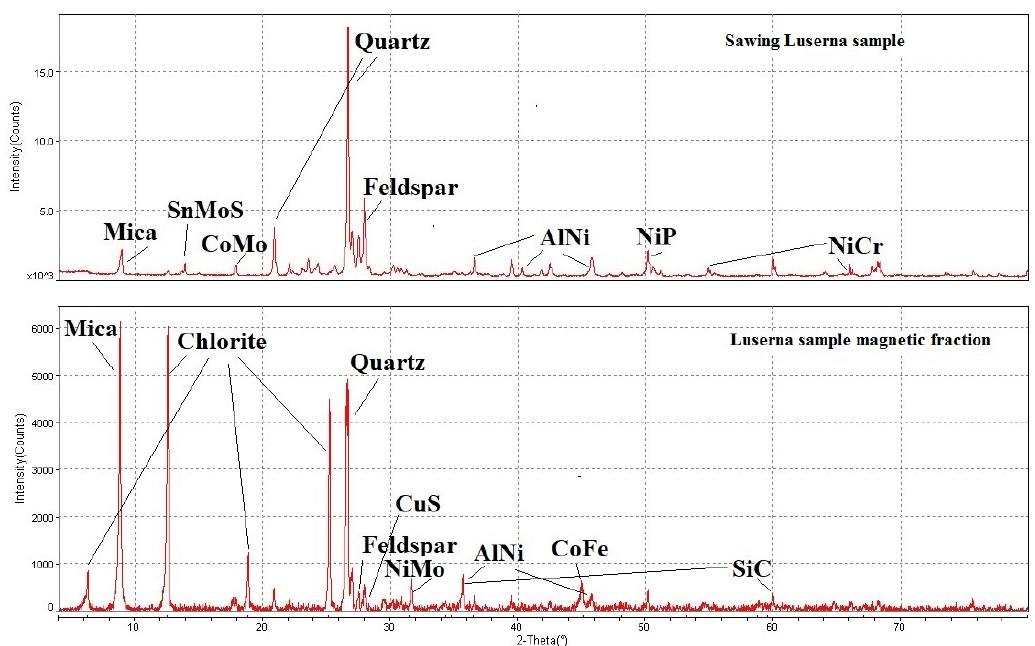
Figure 3. Comparison between the diamond blade sawing Luserna sample spectrum (over) and after magnetic separation (under).